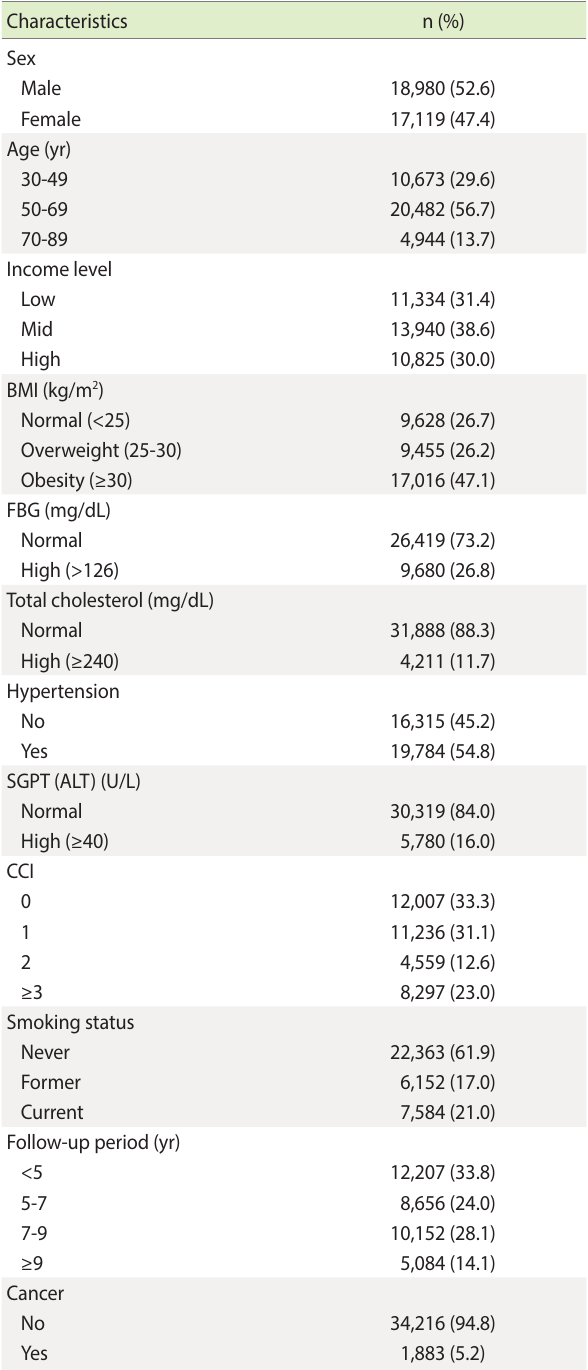
Table 1. Frequency of sample characteristics